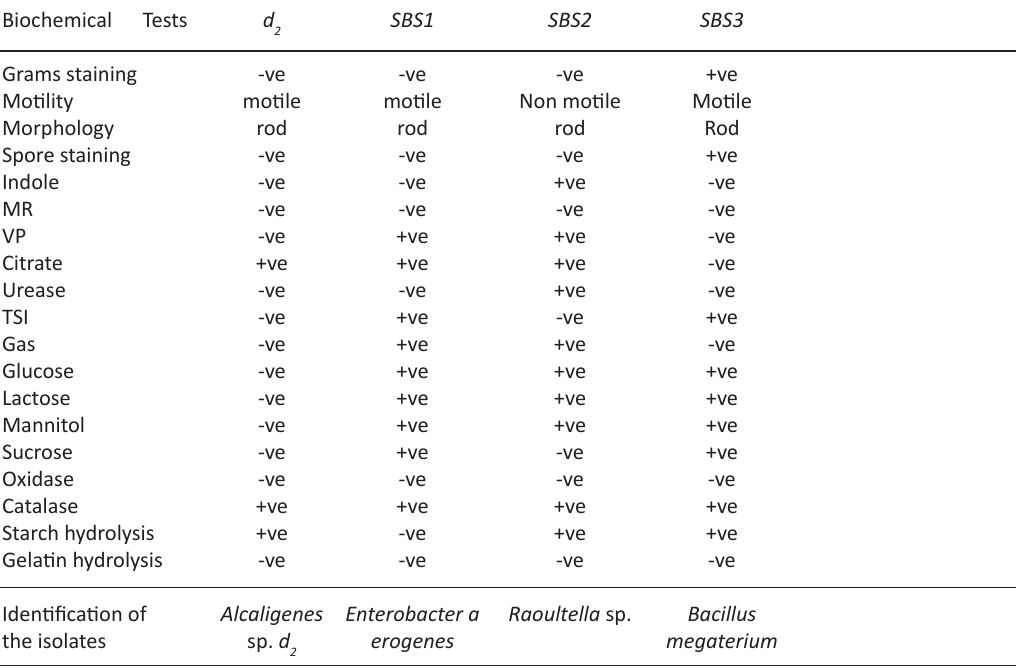
Table 3. Morphological and biochemical characteristics of isolates bacterial strains